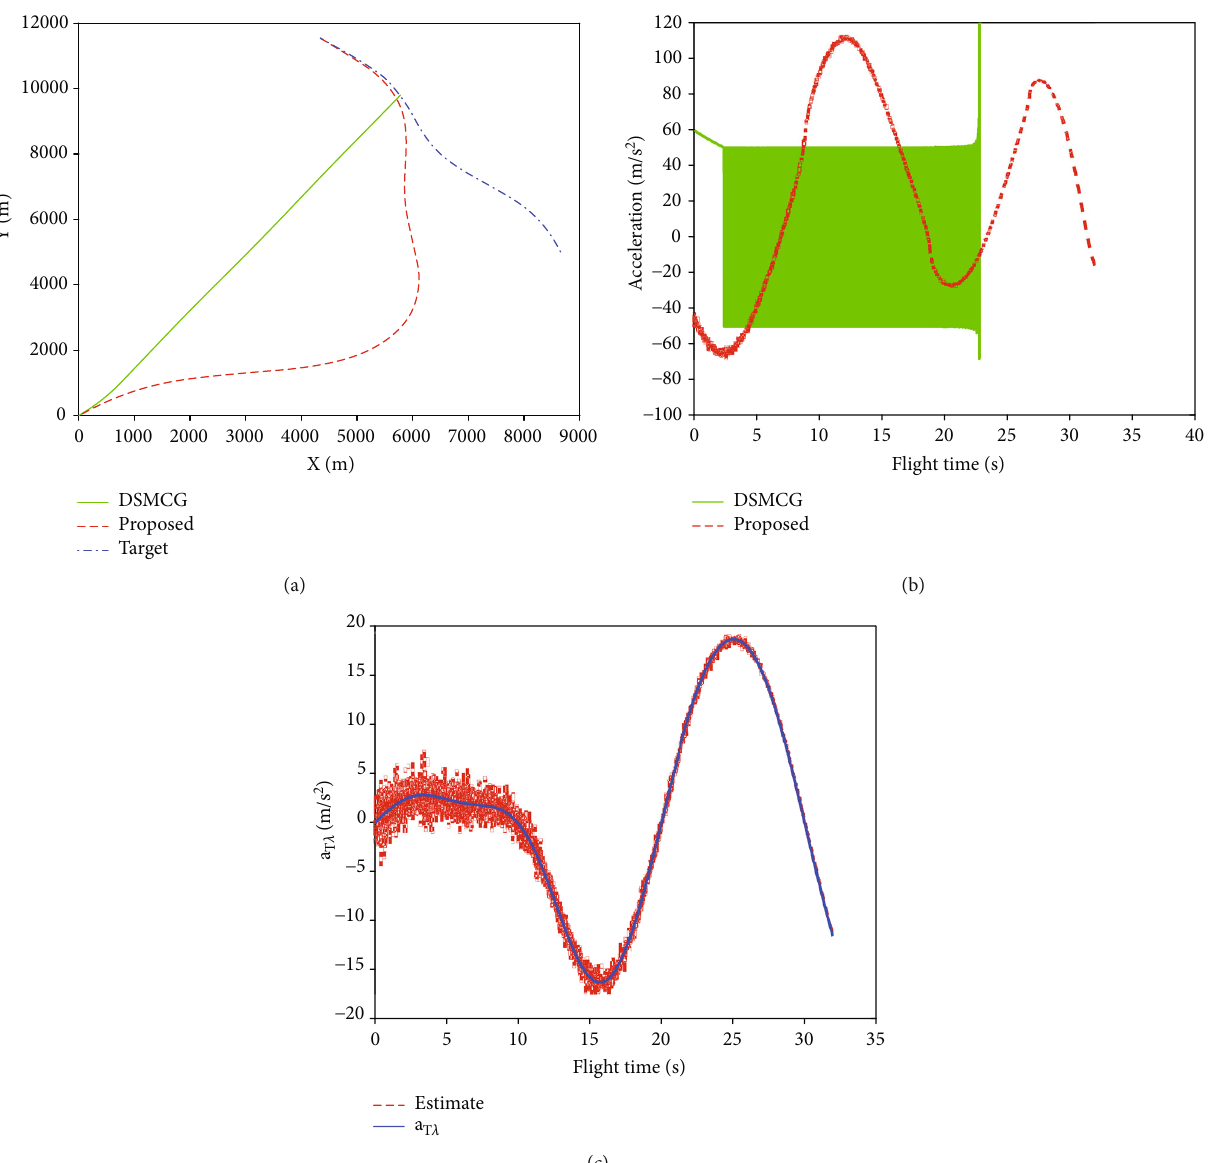
Figure 6: Simulation results under the proposed guidance law for Case 2: (a) interception trajectory; (b) achieved acceleration; and (c) target maneuver